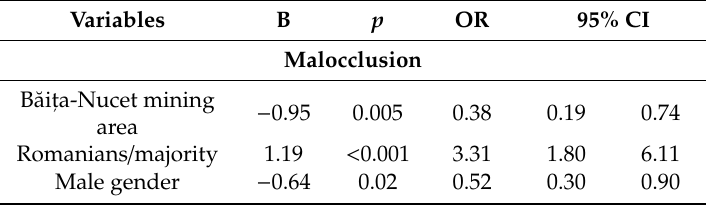
Table 4. Multivariate analysis for total malocclusions.